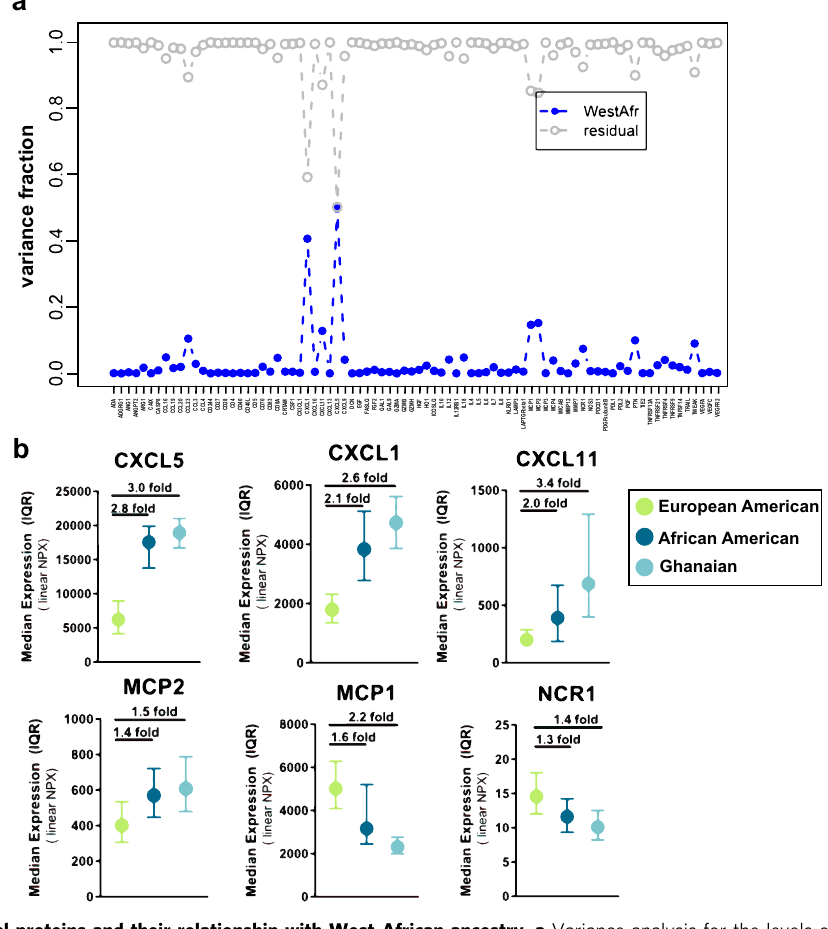
Fig. 4 Immune-oncological proteins and their relationship with West-African ancestry. a Variance analysis for the levels of each of the 82 immune- oncological cytokines assessed as a function of genetic estimation of West African admixture among men without prostate cancer within the NCI- Maryland study ( n = 795). The blue plot represents the proportion of variance that can be explained by the degree of West-African admixture while the grey plot represents the residual variance that remains to be explained by factors other than West-African ancestry. b The median levels of the top six West-African ancestry-correlated immune-oncological proteins were compared between Ghanaian ( n = 654), AA ( n = 374), and EA ( n = 454) men. Error bars represent inter quartile range (IQR). Linearized protein abundances (2^NPX) were used to determine median and IQR for each of the proteins. Data are presented as median± IQR. Source data are provided as a Source Data fi